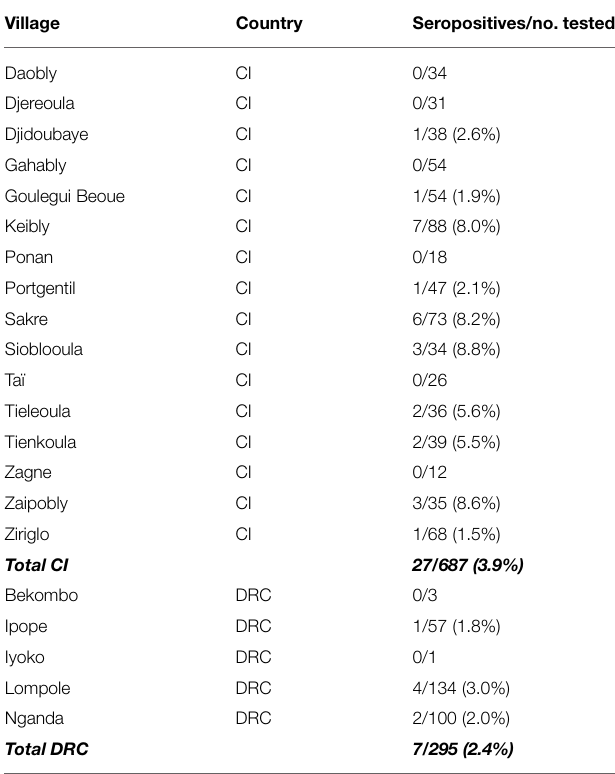
TABLE 1 | Sample composition and proof of antibody-positive sera according to sampling location.